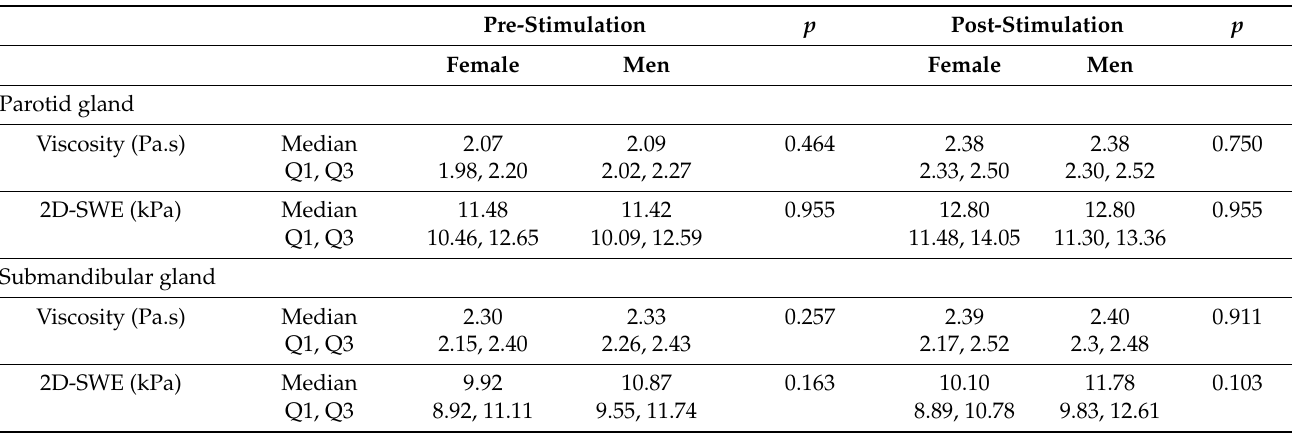
Table 3. Mean viscosity and stiffness values of the parotid and submandibular gland in a group of healthy subjects according to gender, before and after stimulation. Pre-Stimulation p Post-Stimulation p Female Men Female Men